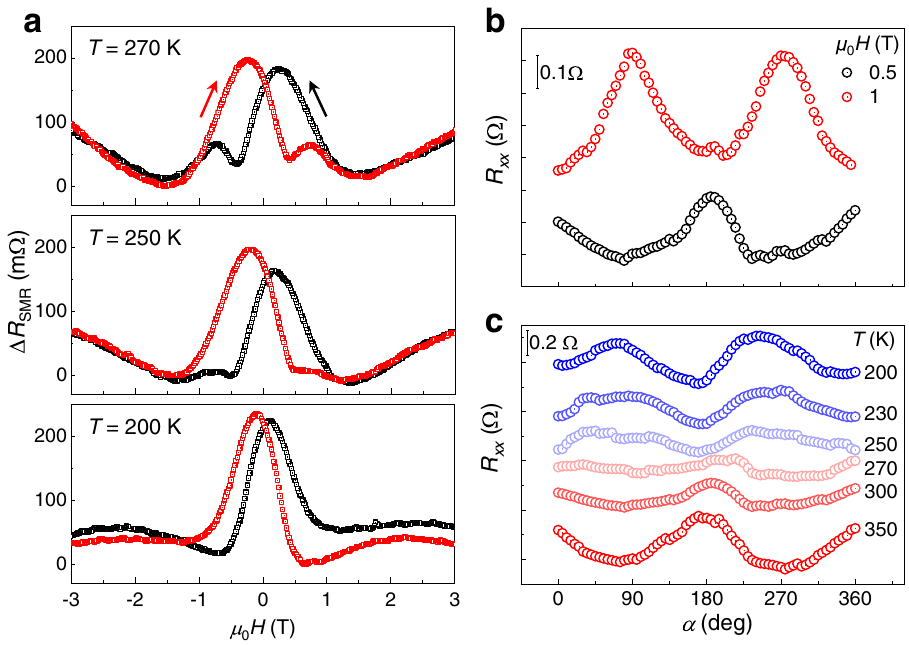
Fig. 3 Temperature-dependent SMR signals. a SMR signals as a function of magnetic fi elds for the Fe 2 O 3 /Cr 2 O 3 /Fe 2 O 3 /Pt sample at various temperatures. b Angle-dependence of SMR curves for the Fe 2 O 3 /Cr 2 O 3 /Fe 2 O 3 /Pt sample at μ 0 H = 0.5 and 1 T. c Corresponding SMR curves at various temperatures at μ 0 H = 0.5 T. The curves are shifted vertically for